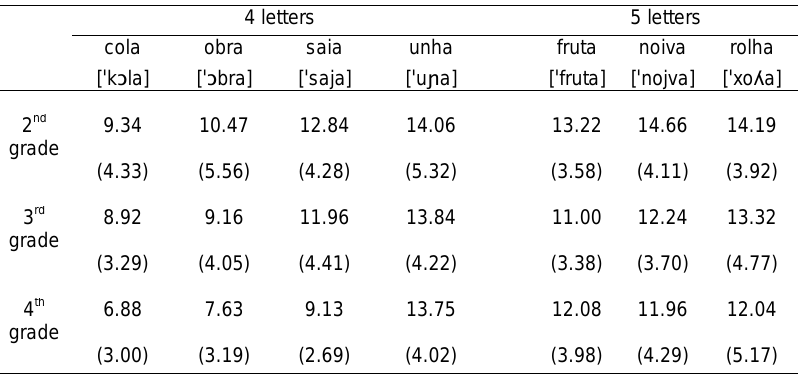
Table 1. Mean number of trials used by Brazilian children to success in the